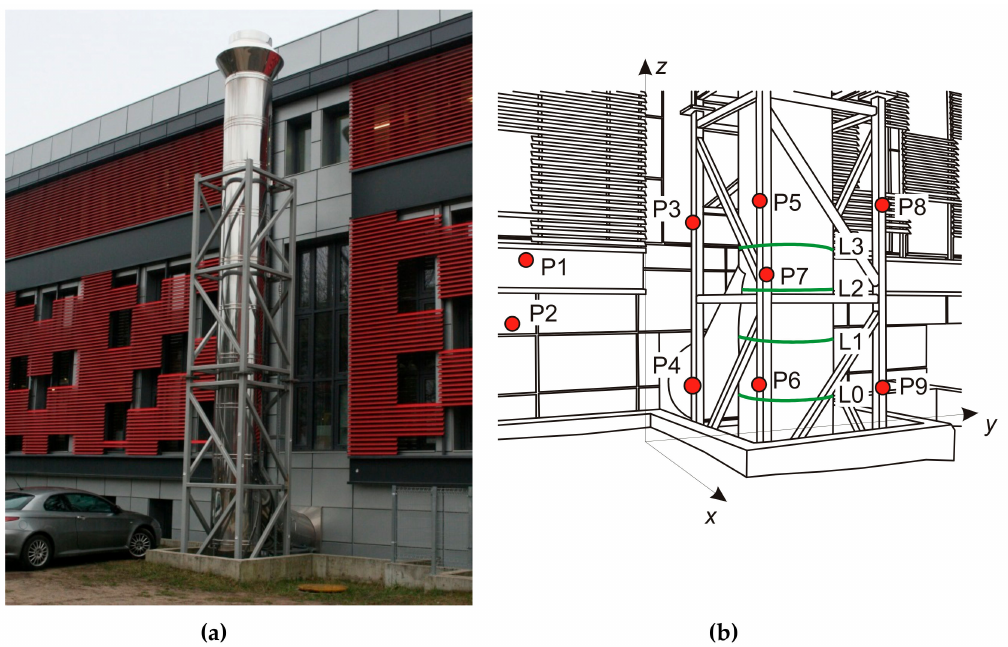
Figure 1. ( a ) View of the steel chimney; ( b ) points arrangement of spatial measuring matrix around measured